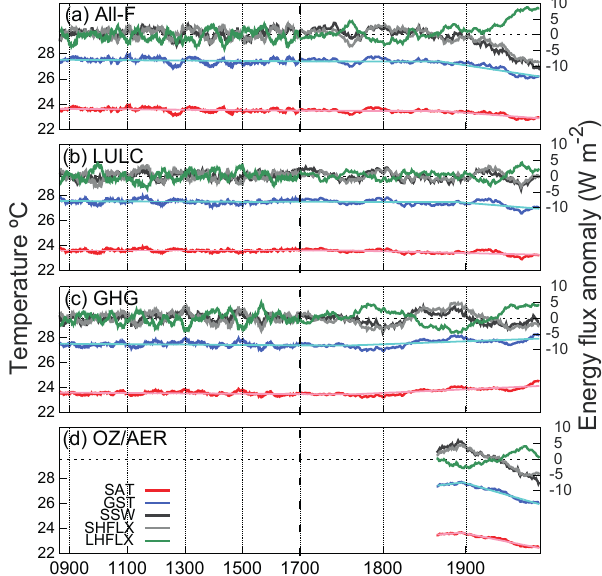
Figure 13. The same as in Fig. 11 but for a grid point located at 2.5 ◦ N, 33 ◦ E over Uganda. Note that the incoming shortwave radi- ation at the surface (SSW) is represented instead of RSW and both LHFLX and SHFLX are